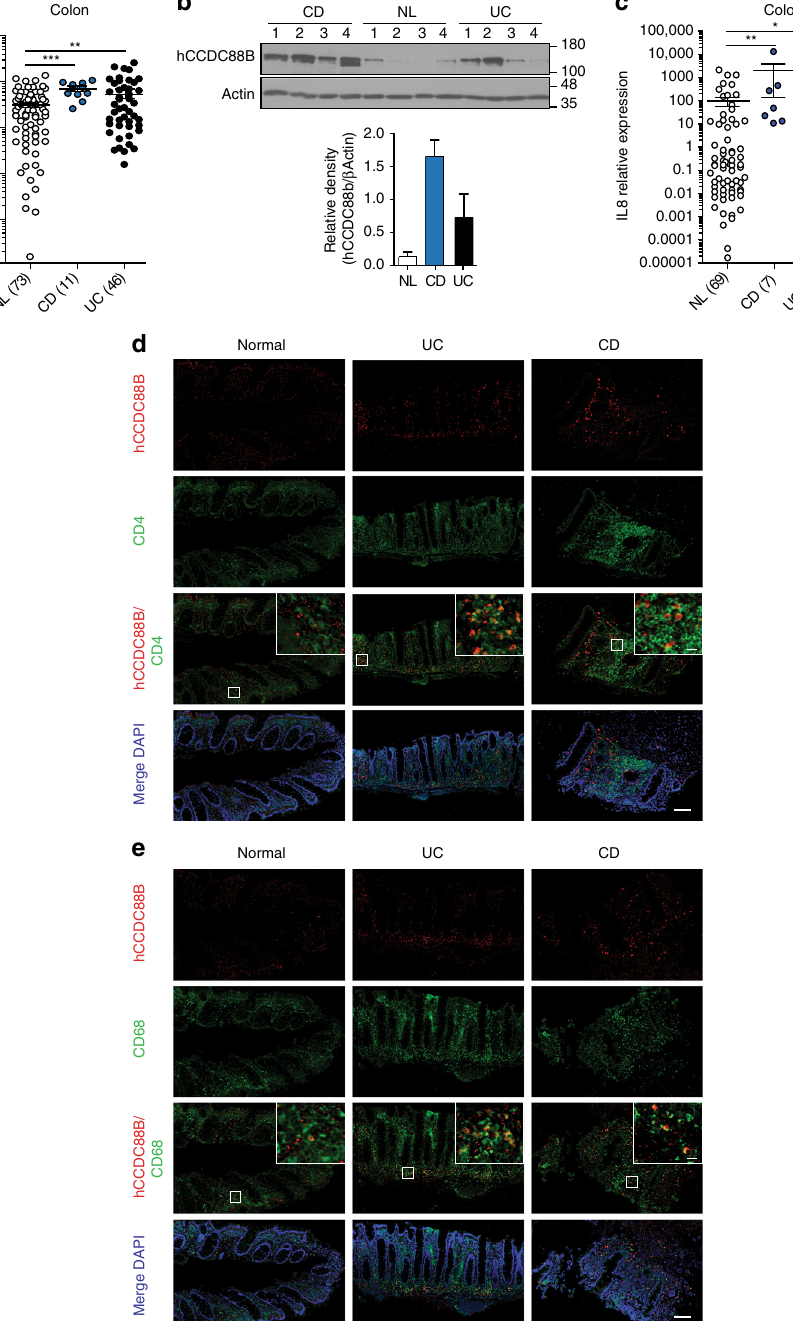
Fig. 6 CCDC88B expression in in fl amed colons from patients with IBD. a CCDC88B mRNA expression in colon tissue samples extracted from surgical specimens of patients with Crohn ’ s Disease (CD, n = 11), Ulcerative colitis (UC, n = 46) or normal control (NL, n = 73). Data represent expression of CCDC88B relative to the ribosomal protein L32 (mean ± SEM; ** P < 0.01, *** P < 0.001; two-tailed Student ’ s t -test). b Immunoblot analysis of CCDC88B and β -ACTIN performed on colonic tissue extracts obtained from surgical specimens of patients with CD ( n = 4), UC ( n = 4) or NL controls ( n = 4). Each lane denotes an individual patient sample. Densitometric quanti fi cation of CCDC88B and β -actin immunoblots. Bar graphs represent normalized relative density of each lane ( n = 4 patient samples). c IL-8 mRNA expression in colon tissues samples from CD ( n = 69), UC ( n = 7) and NL ( n = 38). Data represent expression of IL8 relative to the ribosomal protein L32 (mean ± SEM; ** P < 0.01, *** P < 0.001; two-tailed Student ’ s t -test). d , e Immuno fl uorescence staining of CCDC88B, CD4 and CD68 in colon tissue sections from patients with CD, UC, or NL controls (CCDC88B, red; nuclei blue staining with Hoechst). Isotype control staining for each section is shown. Scale bars, 100 µ m and 10 µ